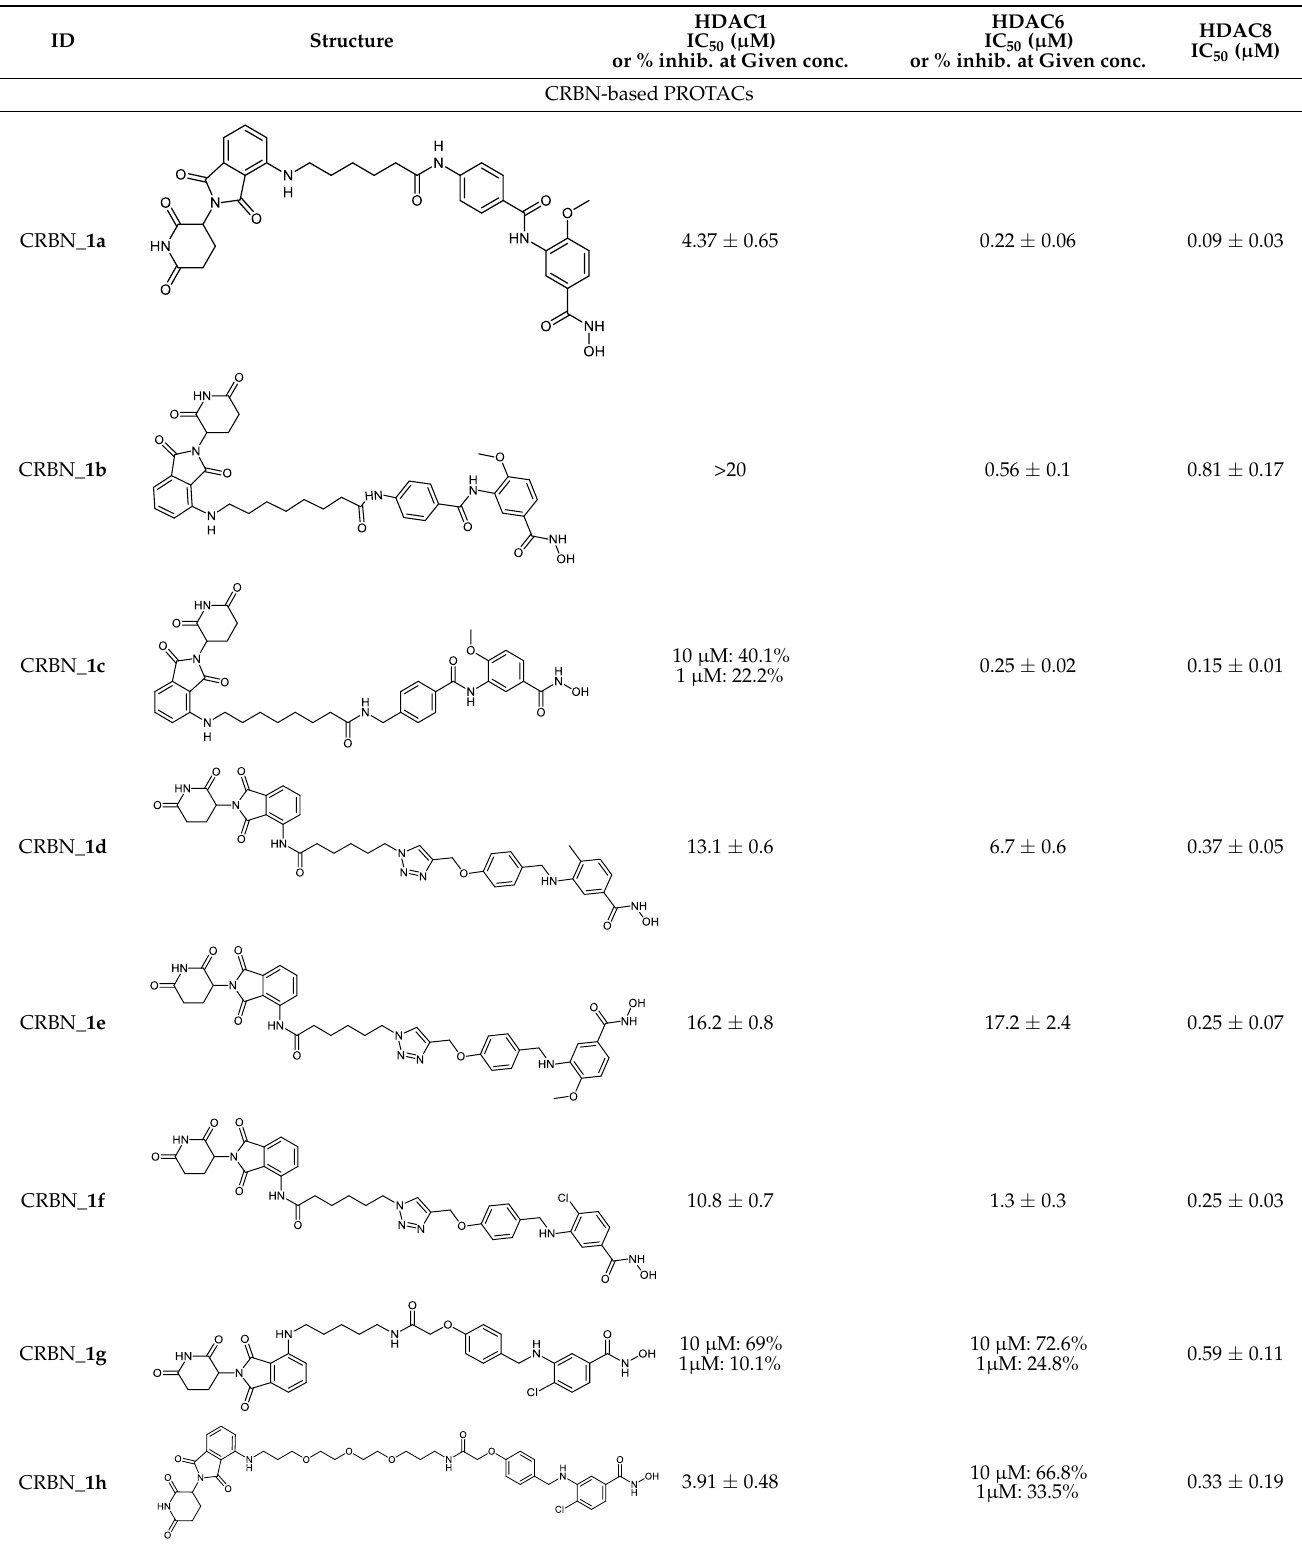
Table 1 . IC 50 values for synthesized Table 1. IC 50 values for synthesized PROTACs.